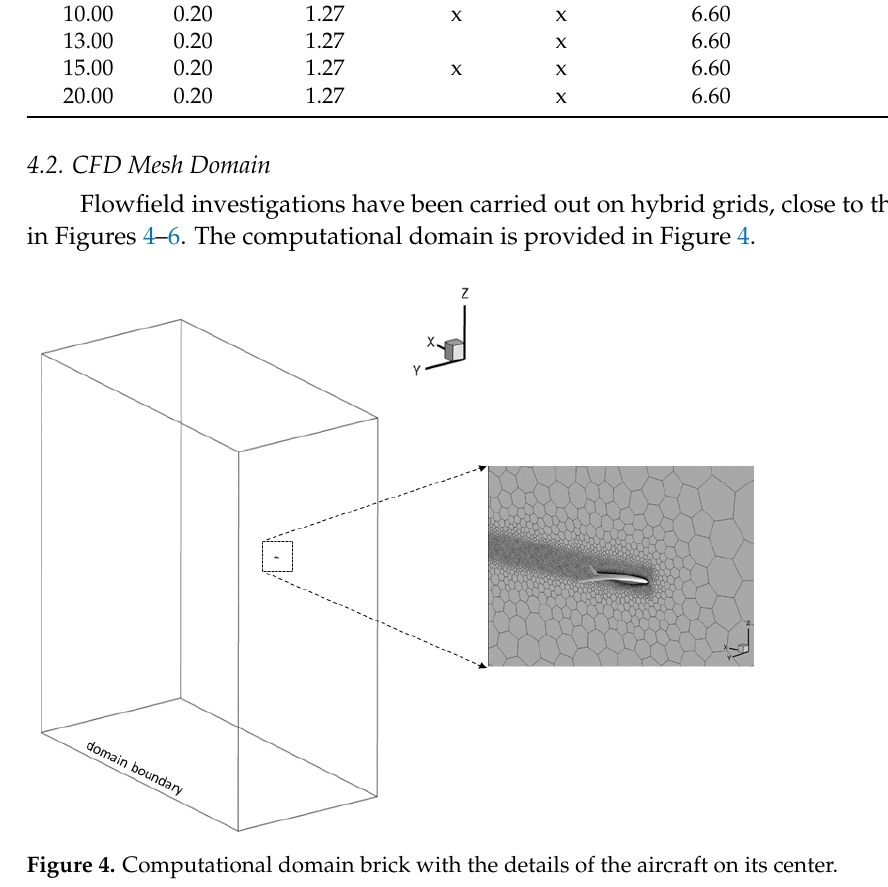
= 6.60 × 10 6 ) conditions. ref